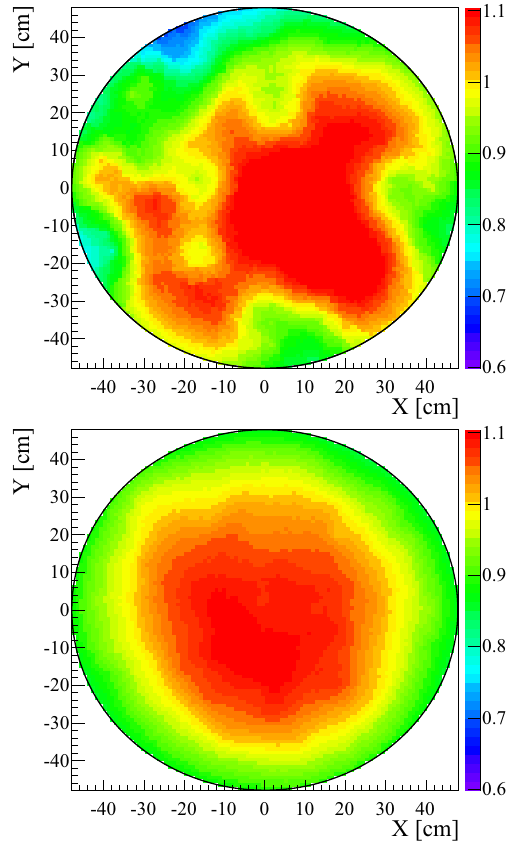
Fig. 22 Relative S2-correction maps compensating the non-uniform charge response of the top and bottom PMT arrays. The response of the top array is more affected by local non-uniformities such as non- operational PMTs. The response of the bottom array is significantly more